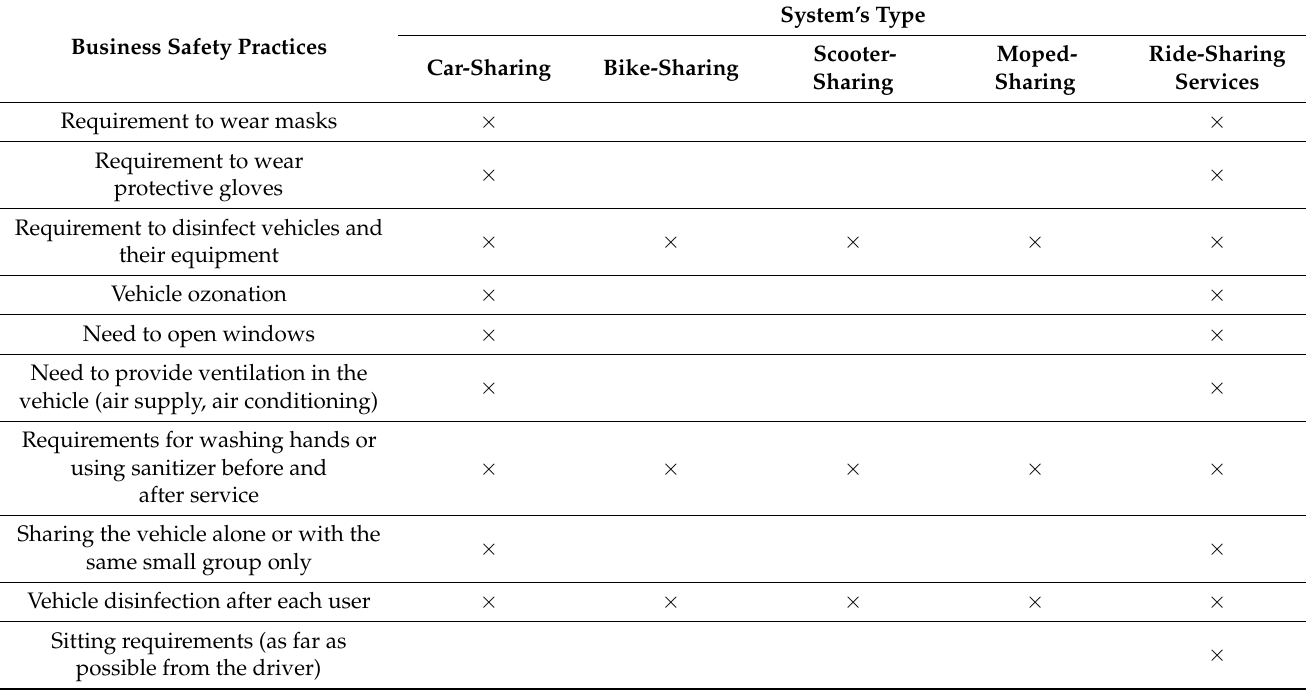
Table 4. Comparison of business practices in new mobility systems—safety